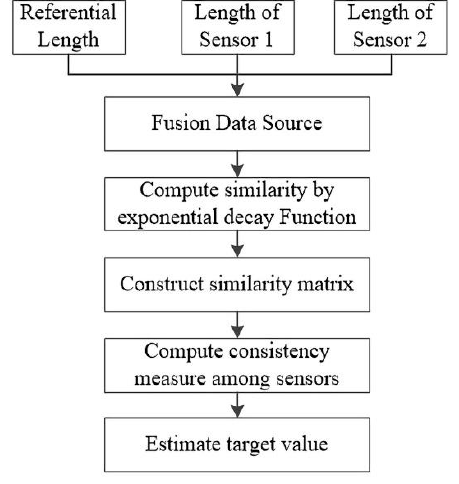
Figure 3. Flowchart on multi-sensor information ensemble.